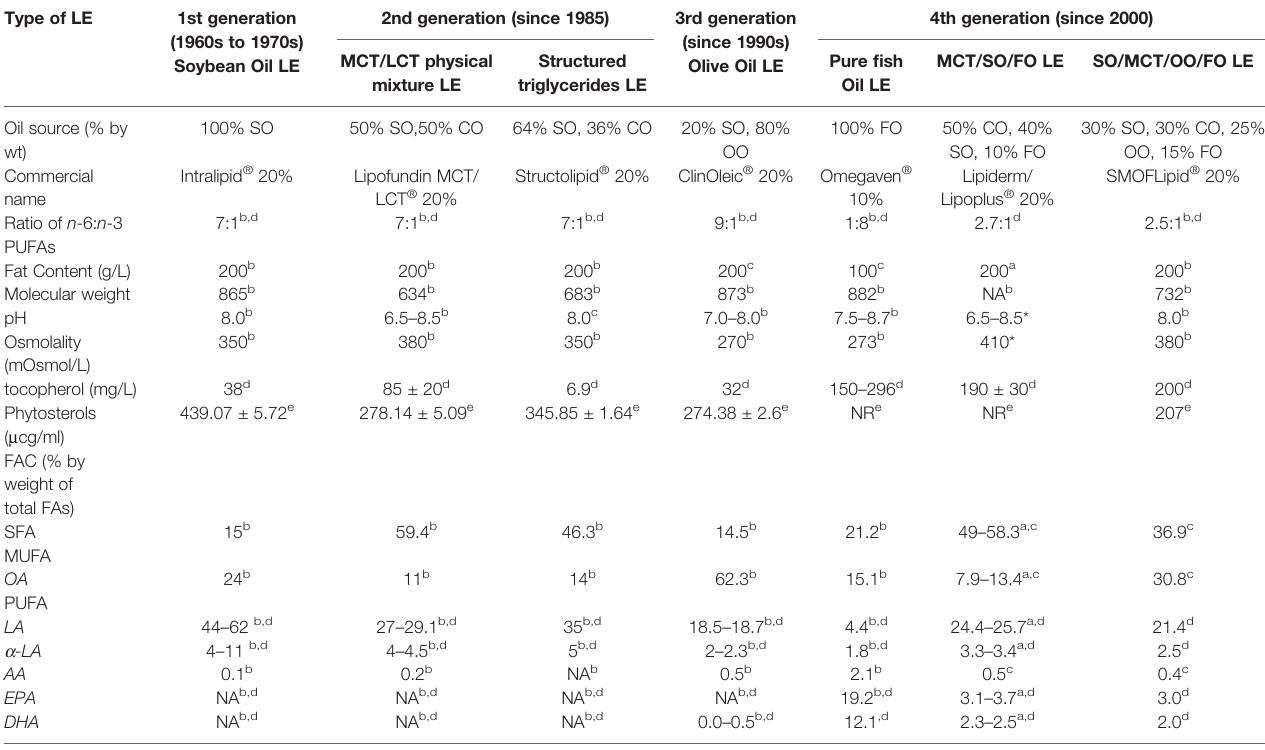
TABLE 2 | Commercially Available Lipid Emulsions in Parenteral